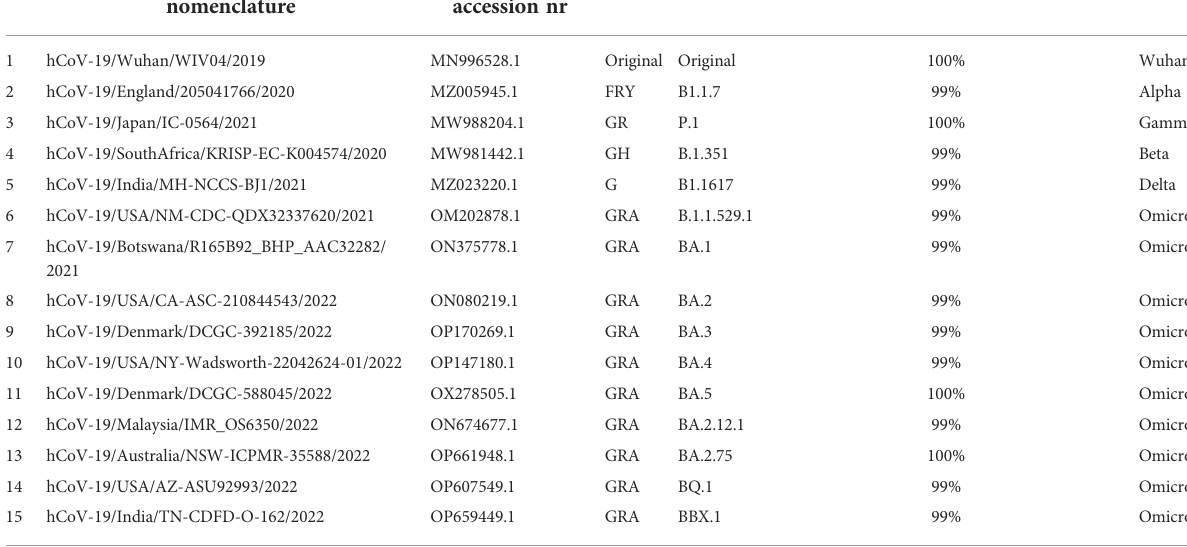
TABLE 1 SARS-CoV-2 prototype and Variants of